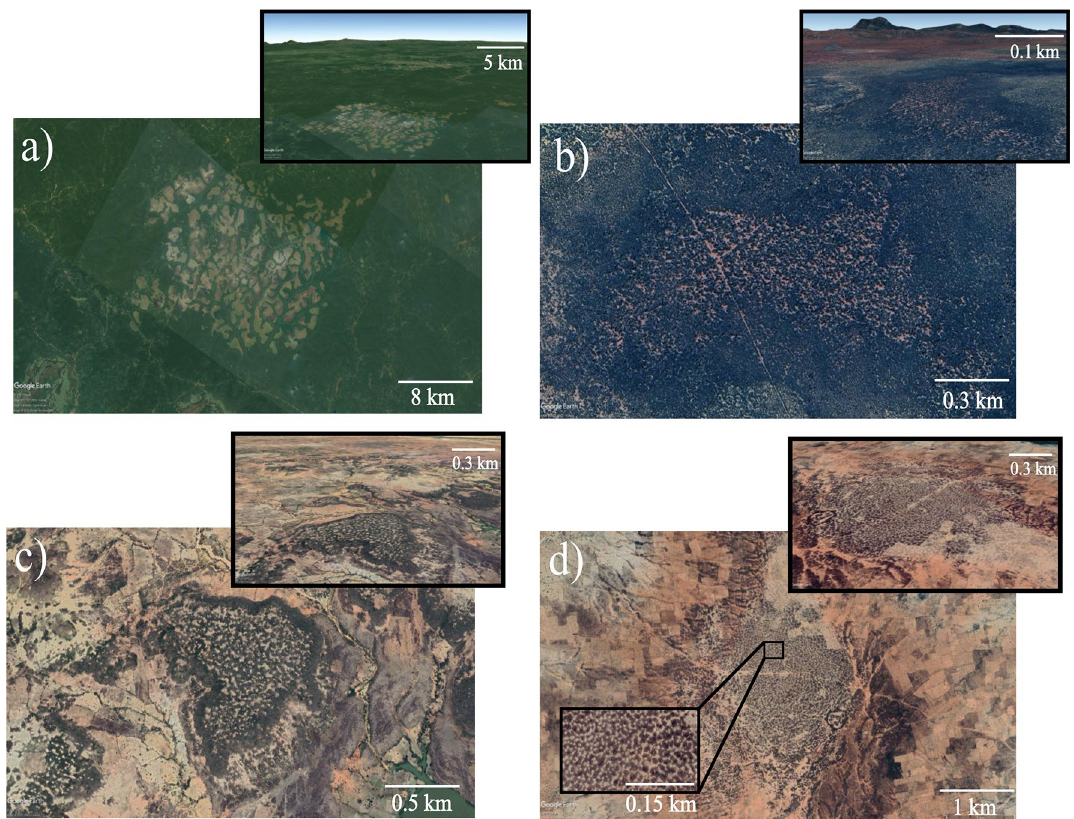
17 ′ 20.99 ″ E), ( b ) Western Australia (29 ◦ 33 ′ 36.16 ″ S 117 ◦ 15 ′ 32.60 ″ E), ( c ) and ( d ) Southwest Niger (12 ◦ 34 ′ 45.10 ″ N 2 ◦ 41 ′ 28.71 ″ E and 12 ◦ 22 ′ 6.72 ″ N 3 ◦ 28 ′ 39.35 ″ E, respectively). The inset (d) show a zoom of the characteristic labyrinth pattern. All the images were retrieved from Google Earth software (https:// earth. google. com/ web/) with a resolution of 1920 × 1080 pixels (total areas of ( a ) 196.5 km 2 ( d ) 24.6 km ). The satellite images were taken on 17 of February, 2021; 22 of September, 2018; 15 of November, 2016; and 12 of February, 2020, respectively. The upper-right insets show the localised patterns to emphasize the topography of the